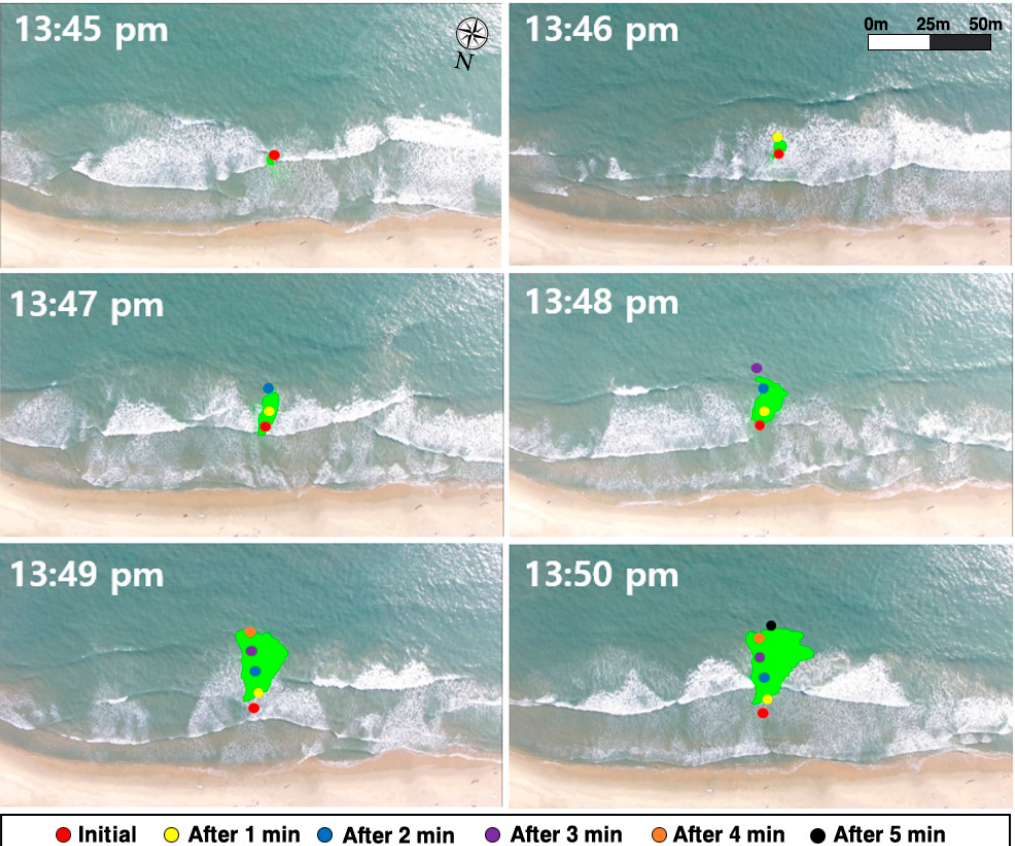
Figure 10. Dye tracking at Haeundae Beach.